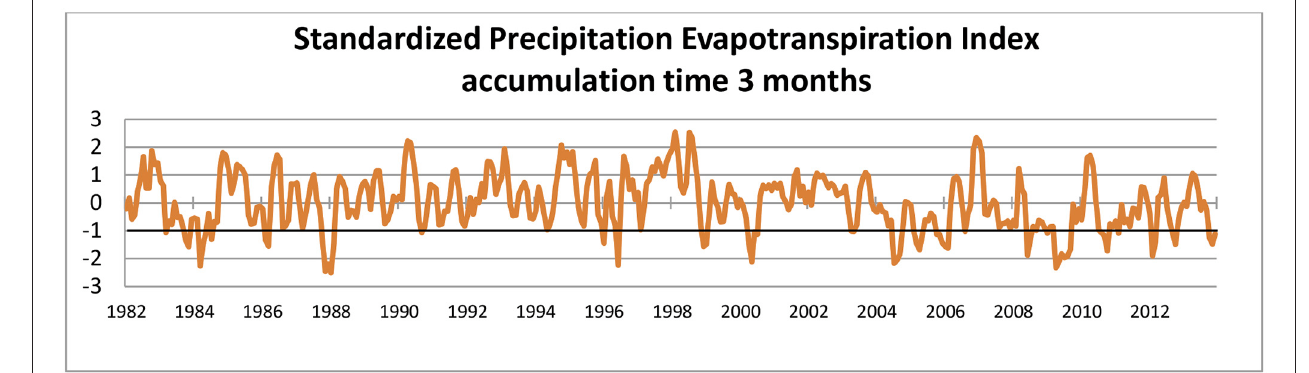
FIGURE 2 | Standardized Precipitation Evaporation Index (SPEI) calculated using CHIRPS Precipitation data and CFSR Evaporation data for 1982–2013. An accumulation time of 3 months was used to show the seasonal climate variability. Values below 0 indicate conditions dryer than average. If such dryer than average conditions are prolonged and occur during the crop growing cycle, drought impacts on agricultural production can be expected.